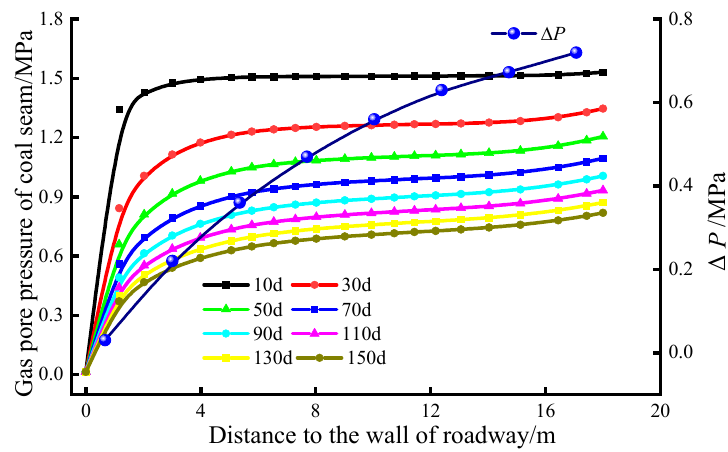
Figure 8. Evolution process of the coal seam gas pressure with time. Figure 9 depicts the evolution process of the coal seam gas pressure along the strike. The closer you get to the borehole, the more noticeable the drop in the gas pressure is. On